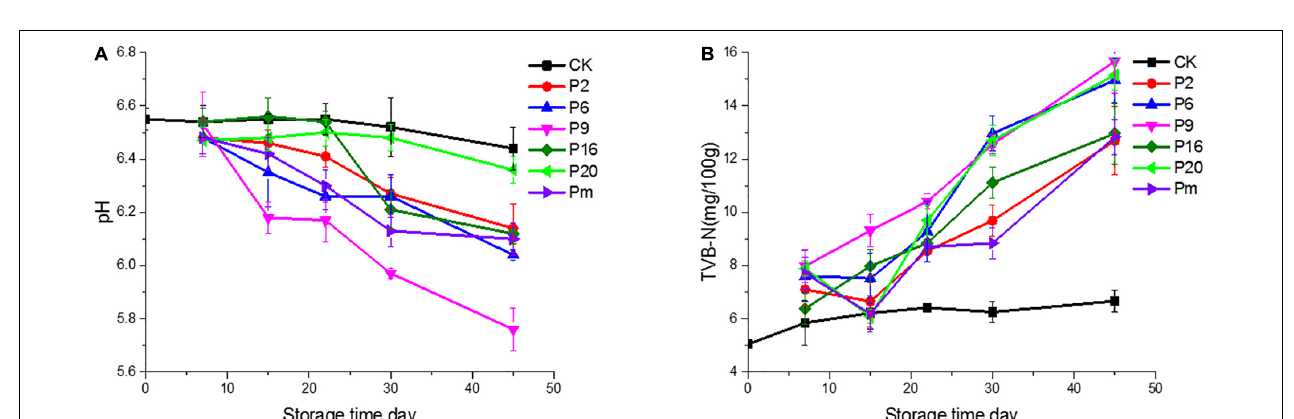
FIGURE 1 | pH values and total volatile basic nitrogen (TVB-N) of bacon inoculated with potential spoilage bacteria, during refrigerated storage. The error bars were derived from the standard deviation between replicates ( n = 3). CK, Control; P2, Staphylococcus xylosus ; P6, Leuconostoc mesenteroides ; P9, Carnobacterium maltaromaticum ; P16, Leuconostoc gelidum ; P20, Serratia liquefaciens ; Pm, The five strains in combination.